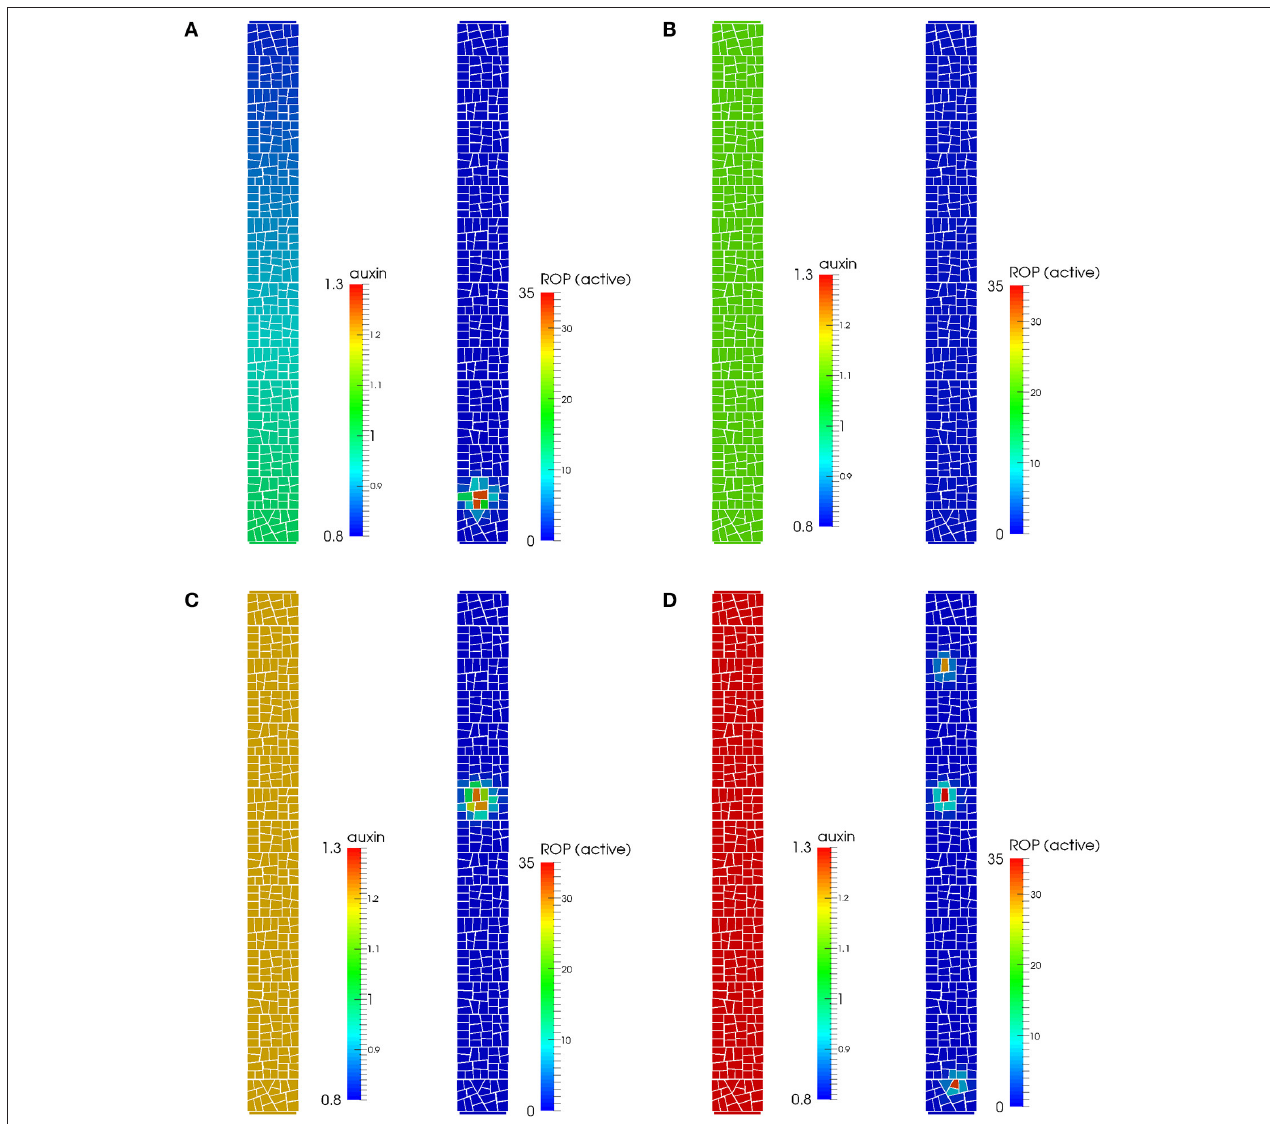
FIGURE 2 | Auxin gradient and pattern of active ROP in a model of auxin-driven ROP-activation. (A) When an auxin gradient is present, active ROPs can localize centrally toward the basal end along the outer membrane of the epidermal cell, similar to the experimentally observed pattern. (B) A low activation of ROPs is seen for a constant auxin level of 1.1, with no clear peaks of active ROP forming. (C) For a constant auxin level of 1.2, the active ROP peak localizes closer to a middle position along the cells apical-basal axis. (D) For a constant auxin level of 1.3, several ROP peaks appear throughout the